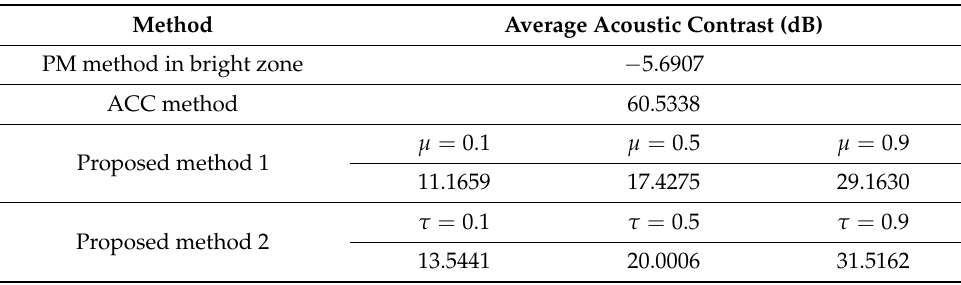
Table 6. Average acoustic contrast of different methods relative to frequency for three-dimensional experiment.